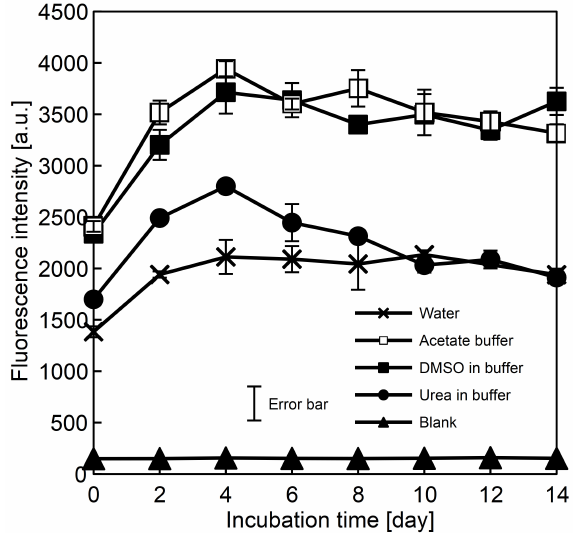
Figure 1. The ThT florescence intensity recorded at 485 nm for the samples of K-peptide incubated at 37 ◦ C up to 14 days. The peptide was dissolved in: (cid:53) water; (cid:3) acetate buffer, pH = 4, without additives; (cid:110) acetate buffer with dimethyl sulfoxide and (cid:108) acetate buffer with urea. Symbol (cid:115) refers to blank, control solutions without the K-peptide. Experimental uncertainty is presented as standard